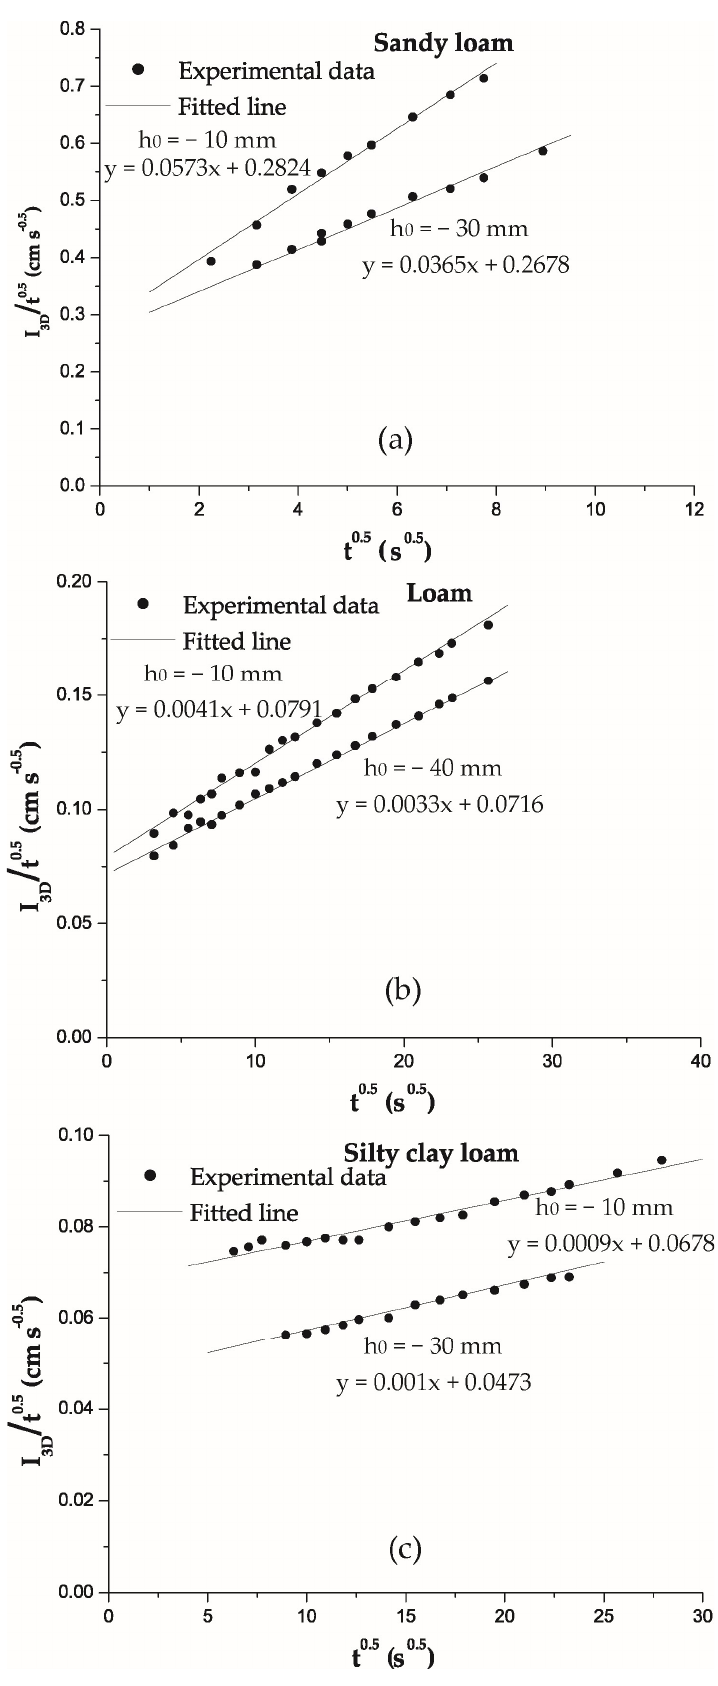
Figure 2. Linear representation of three-dimensional experimental infiltration data and fitted linear lines for various pressure heads, h 0 , for ( a ) sandy loam, ( b ) loam, and ( c ) silty clay loam soil.